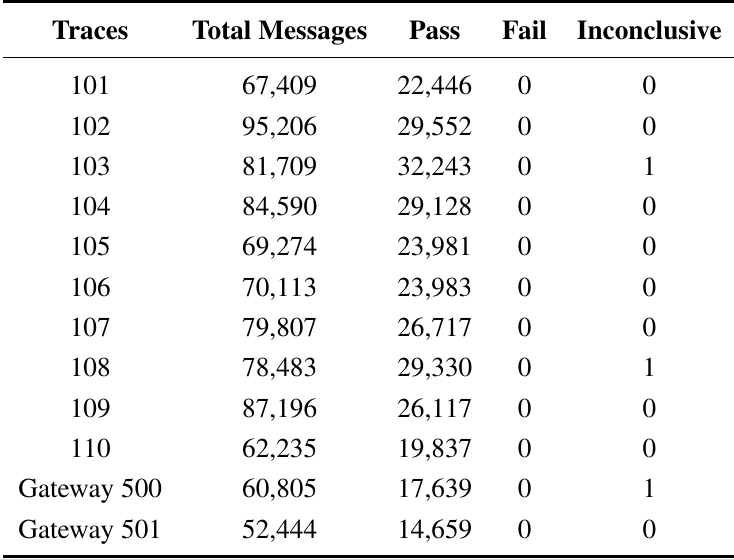
Table 2. Test results for Property 2 (Day